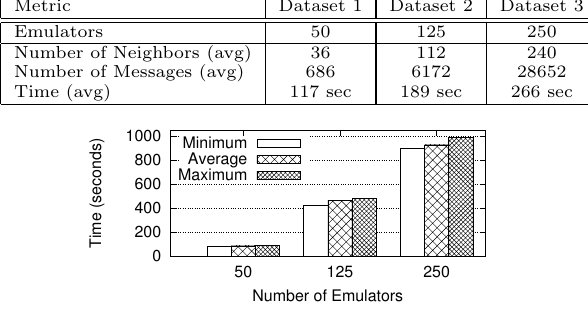
Table 3: Application execution statistics. Metric